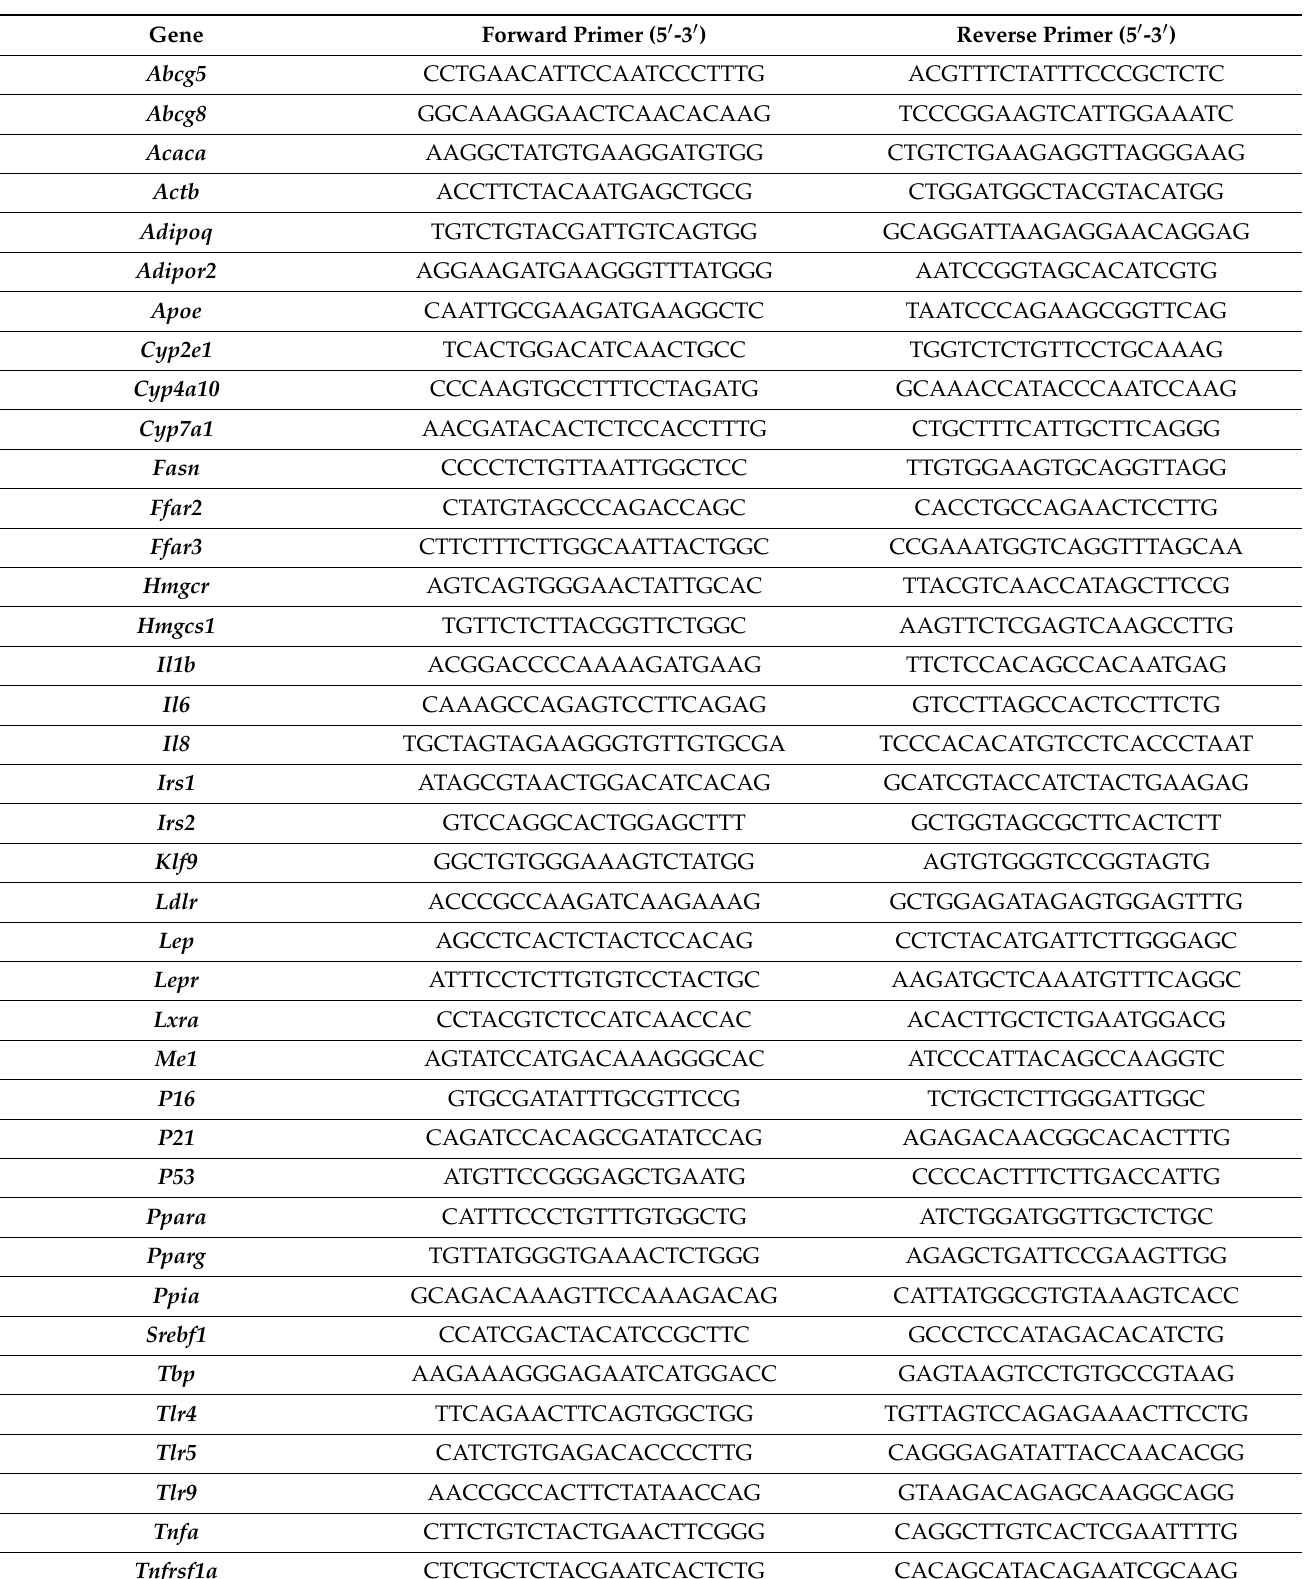
Table 2. Primers used in